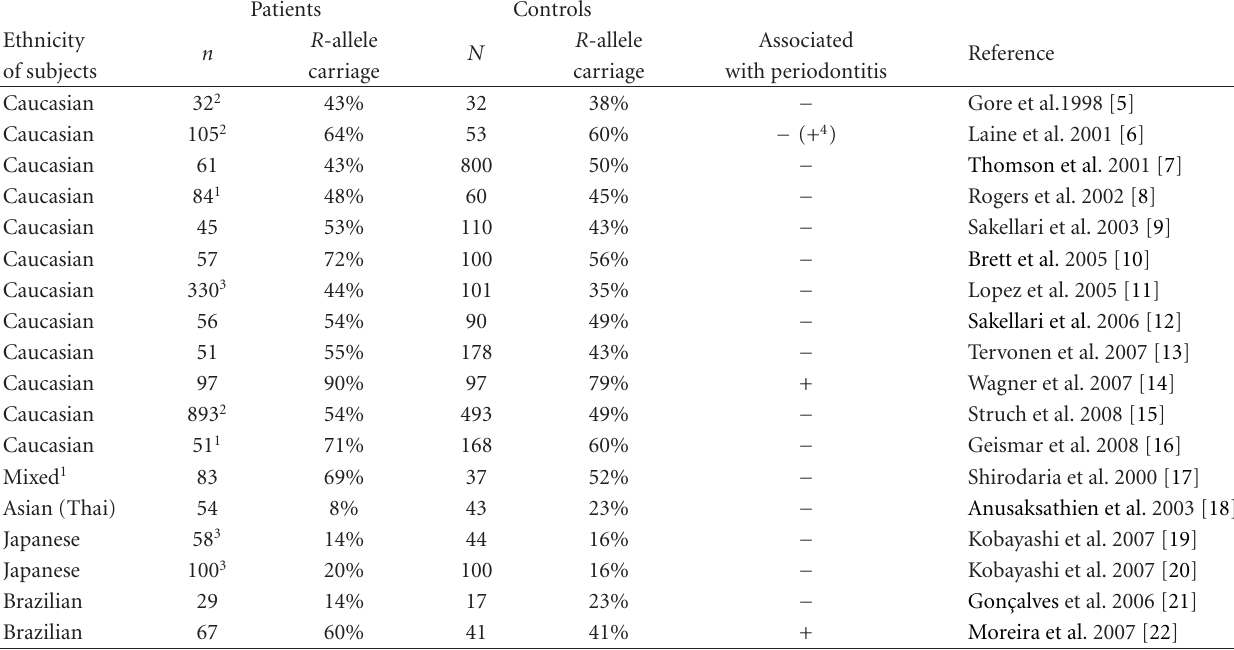
Table 1: IL1A -889 (+4845) C > T gene polymorphisms and carriage rate of the Rare ( R )-allele in case-control studies and association with susceptibility to chronic